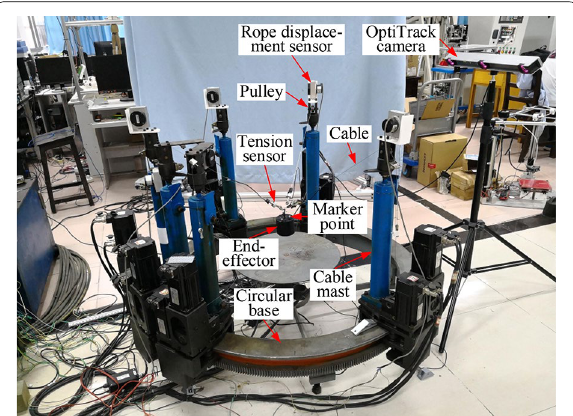
Figure 17 Experiment prototype of the